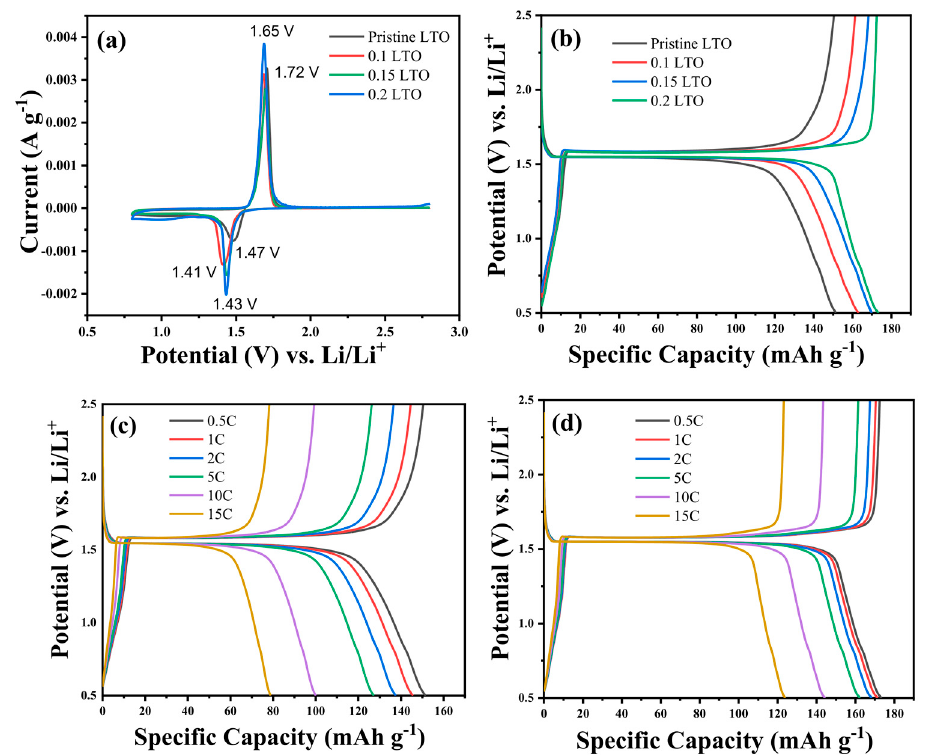
Figure 4. ( a ) Cyclic voltammetry of all LTO, ( b ) the charge–discharge profile for pristine LTO and iodide-doped LTO at 0.5C; the high-rate charge–discharge performance of ( c ) pristine LTO, and ( d ) 0.2 LTO.